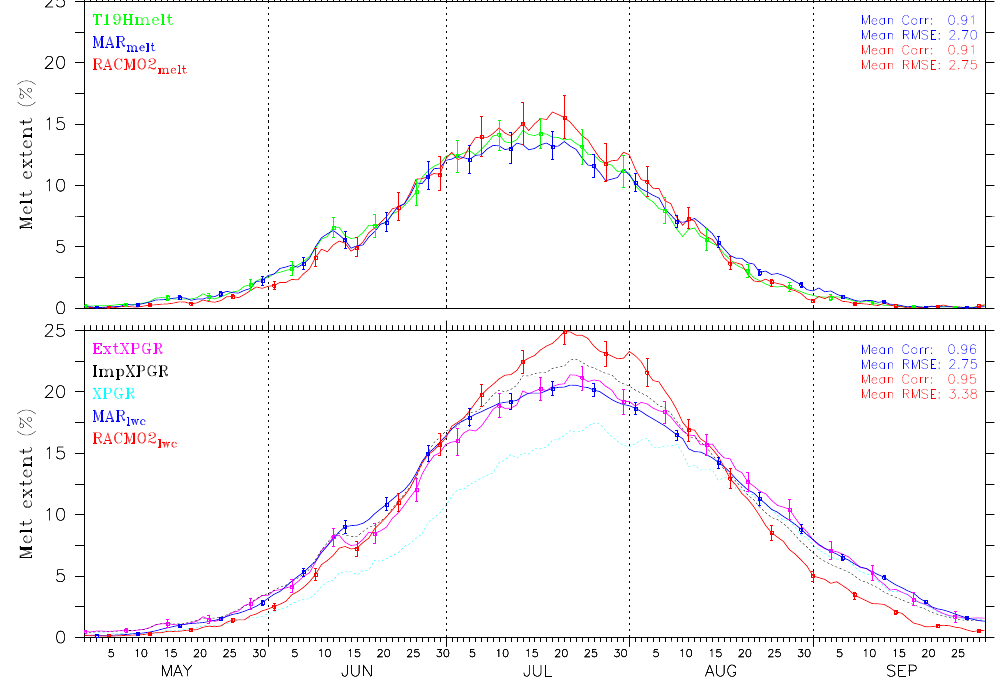
Fig. 3. Mean seasonal cycle (1979–2009) of melt area (in % of GrIS area) simulated by MAR and RACMO2 as well as retrieved from the spaceborne passive microwave data set with the different techniques discussed in the text (see Table 2). The error bars show a positive/negative change of the threshold used to derive the melt extent as listed in Table 2. The statistics (i.e. the mean correlation coefficient as well as the mean Root Mean Square Error over 1979–2009) between MAR (in blue)/RACMO2 (in red) and the T19H melt (resp. ExtXPGR) algorithms are also listed.